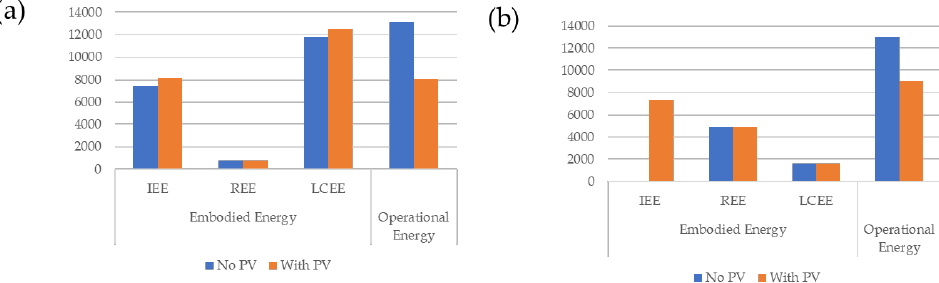
Figure 5. Impact of a PV system on life cycle embodied and operational energies: ( a ) Impact from zero to 25 years; ( b ) from 26 to 50 years.